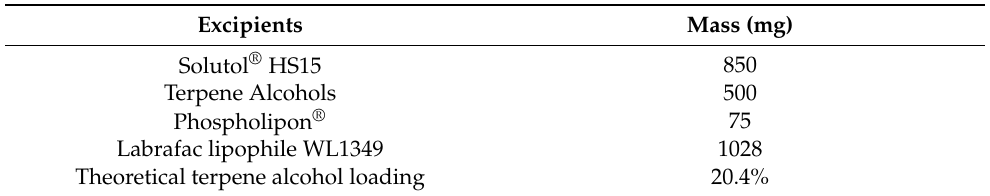
Table 1. Composition of the LNP. Theoretical terpene alcohol loading was calculated as the mass of terpene alcohols over the mass of all the compounds. Excipients Mass (mg) Solutol ® HS15 850 Terpene Alcohols 500 Phospholipon ® 75 1028 Theoretical terpene alcohol loading